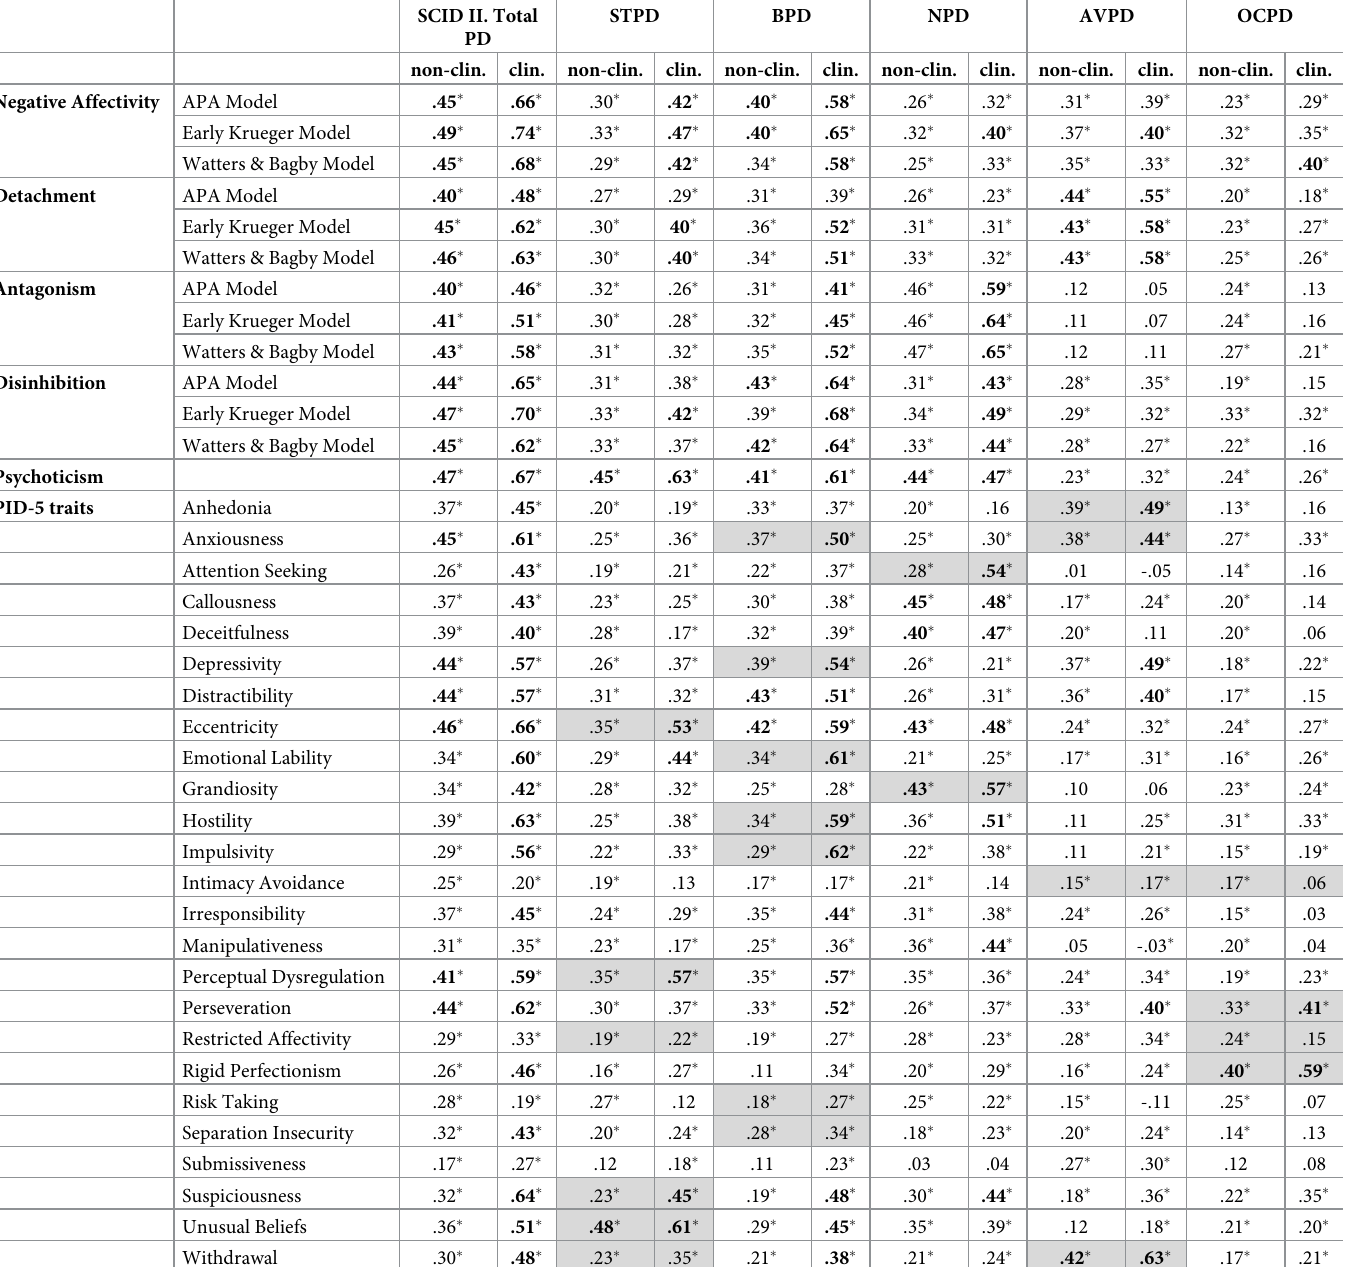
Table 6. Pearson correlations between PID-5 traits, SCID-II total personality disorder score and DSM-IV personality disorders proposed to be retained in DSM-5 measured by SCID-II. SCID II. Total STPD BPD NPD AVPD OCPD PD non-clin. clin. non-clin. clin. non-clin. clin. non-clin. clin. non-clin. clin. non-clin. clin. Negative Affectivity APA Model .45 �